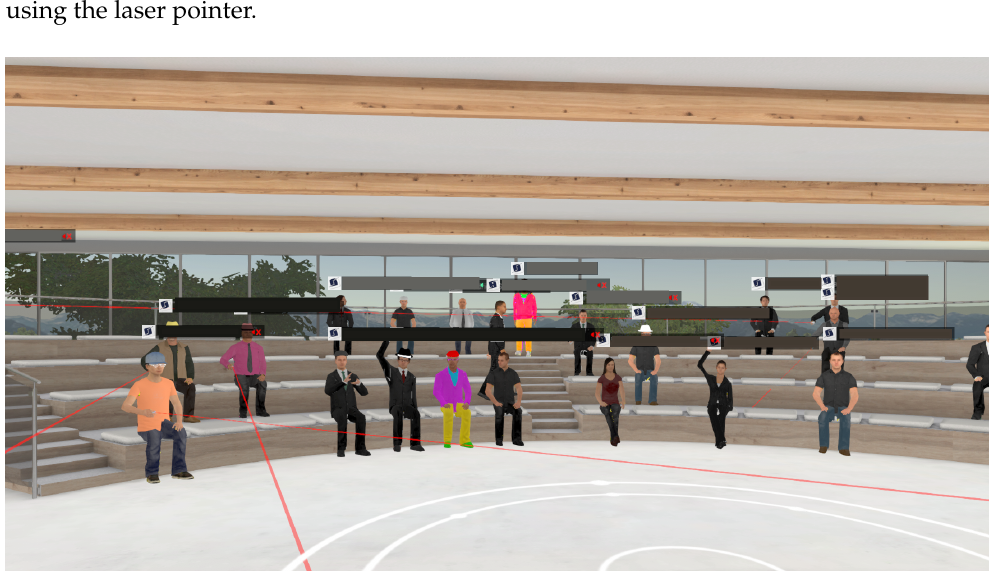
Figure 6. Students sitting in the auditorium; students are engaged in activities in LearnSpace such as waving, applauding, and using the laser